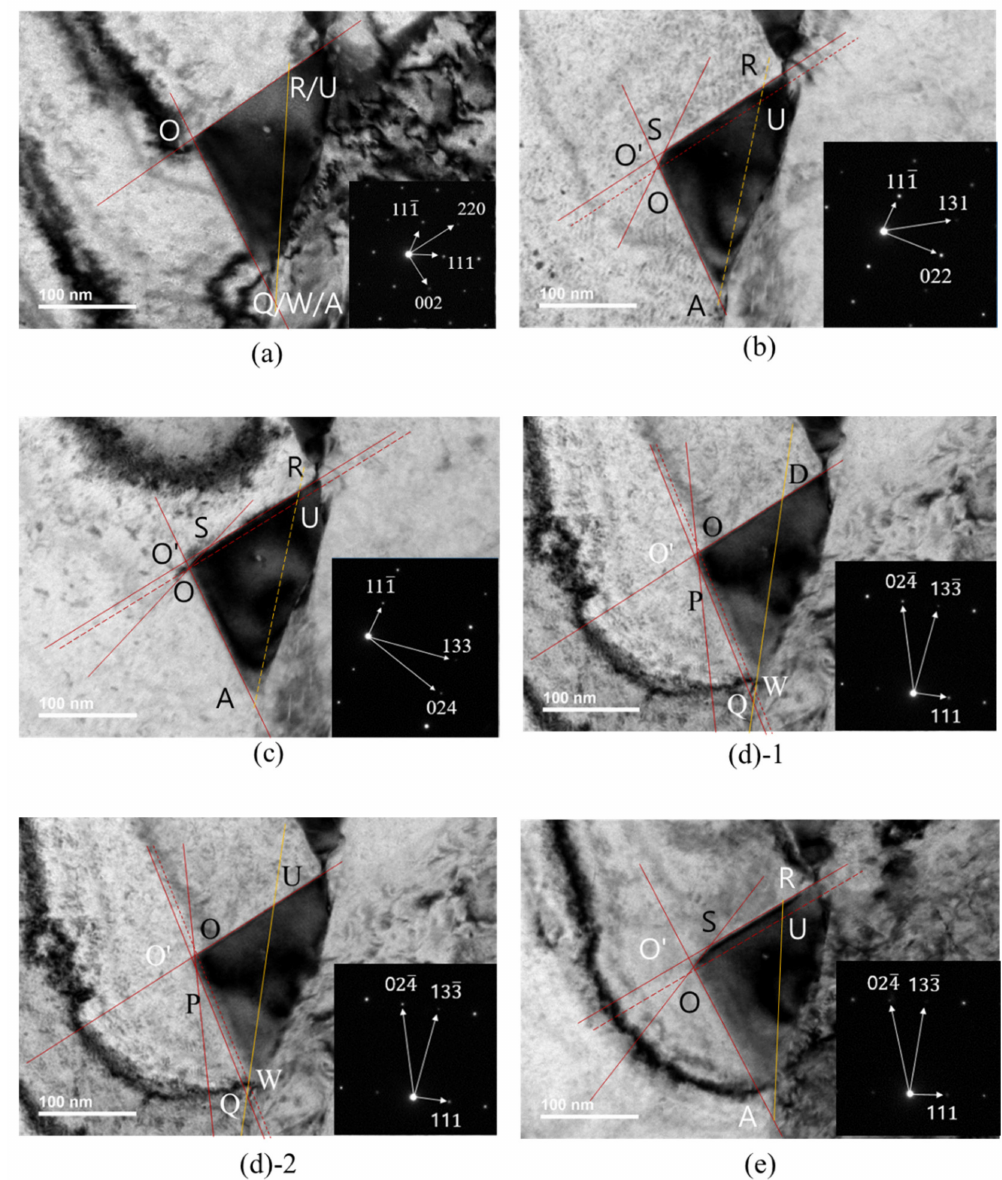
Figure 6. Duplication of Figure 4 with additional lines and position marks corresponding to Figure 5. ( a , b , c , e ) correspond to Figure 4a,b,c,e respectively. Both ( d1 , d2 ) corresponding to Figure 4d are same except position mark D in ( d1 ) and U in ( d2